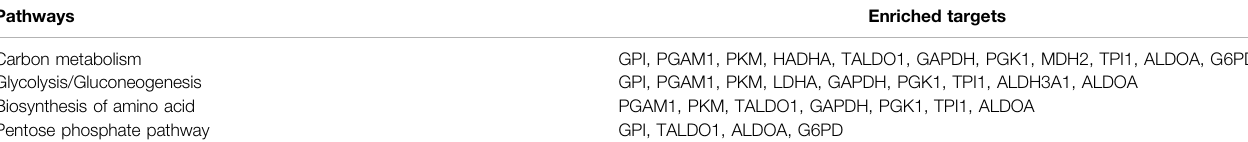
TABLE 2 | Pathways interfered by reTFAE, and proteins enriched in each pathway.